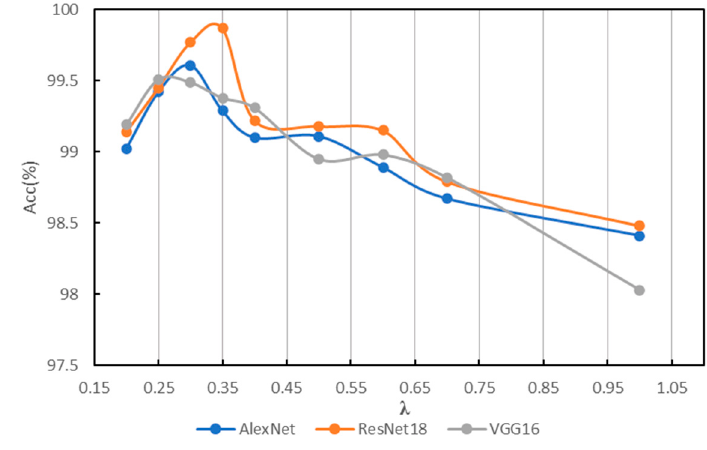
Figure 10. Results of different λ on CWRU.